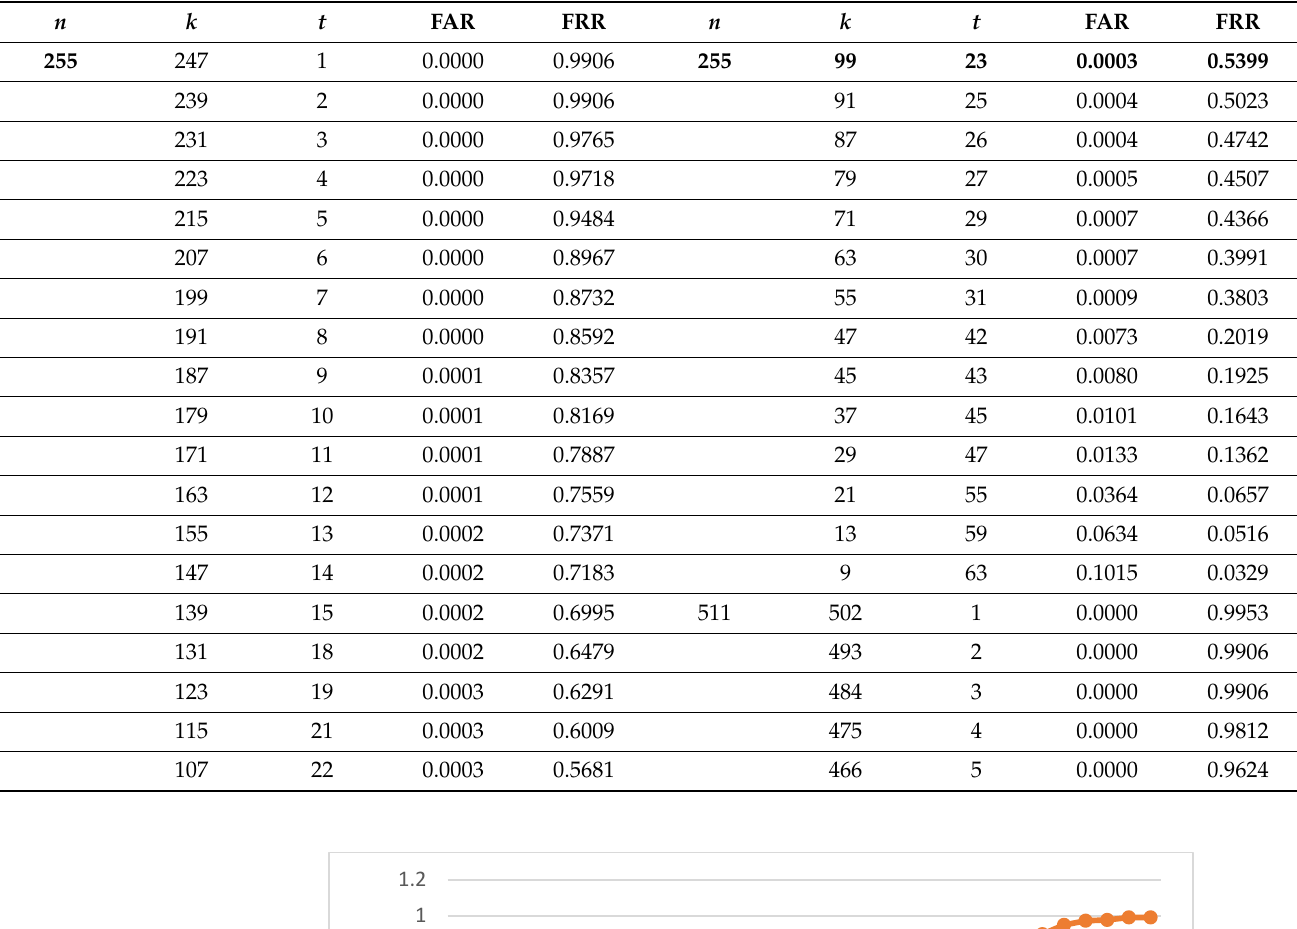
Table 5. The results of the second experiment ( n = 255 and n = 511) for the BioIdent dataset.